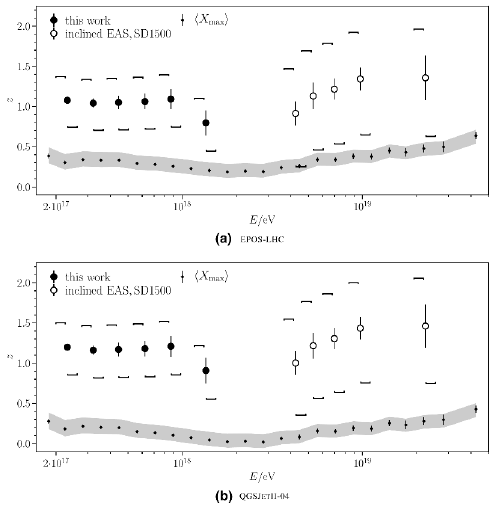
Figure 10. z -scale factor from this work (filled circles), from measurements of inclined air showers at higher energies (open circles) and from < X max > measurements with the